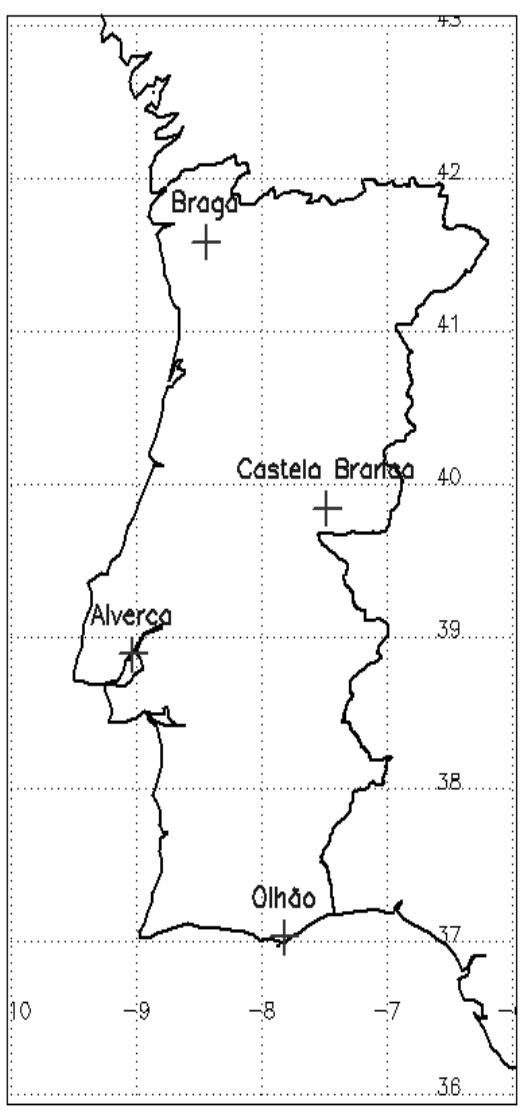
Fig. 1. Map showing the geographical location of the electrical dis- charges sensors in Figure 1. Map showing the geographical location of the electrical discharges sensors in 646